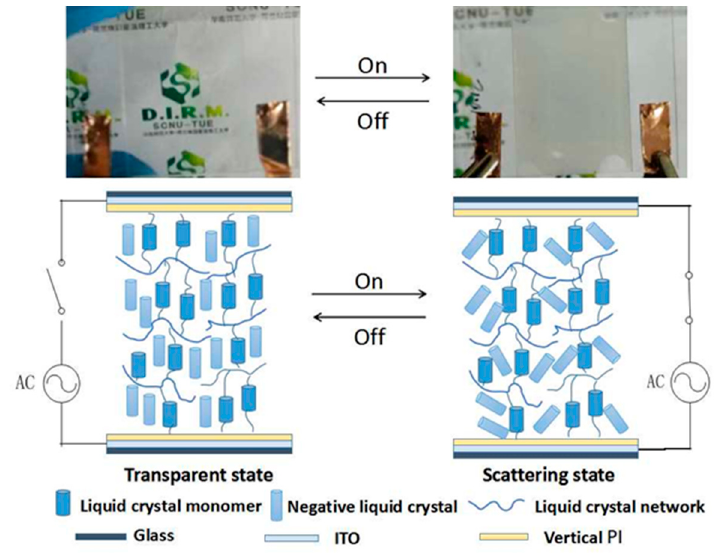
Figure 1. Schematic of PSLC device without electric field (transparent state) and with electric field (scattering state).